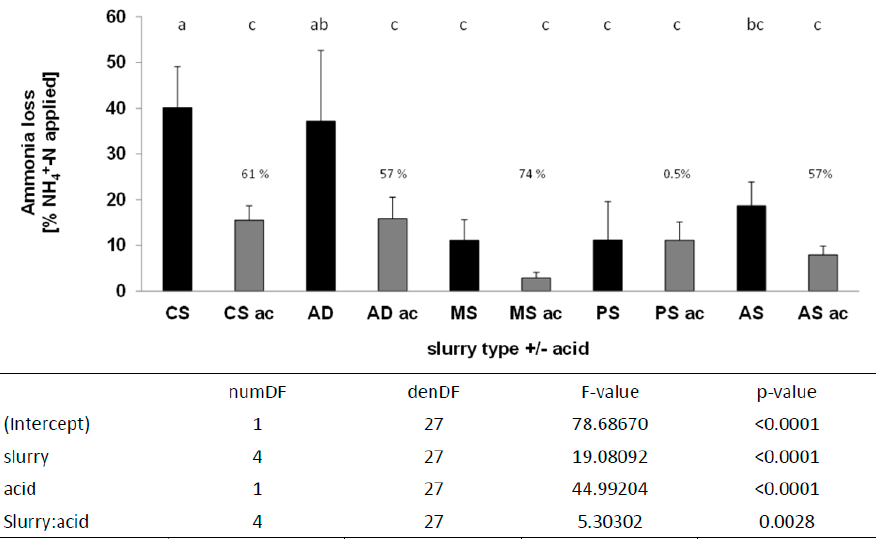
Figure 3. NH 3 loss after application of five different slurries with and without acidification by trail hoses, first winter wheat trial. Applied NH 4+ -N kg ha − 1 : CS = 84.8, AD = 79.5, MS = 78.75, PS = 84.42, and AS = 79.5, n = 4; mixed effects model, HSD test p < 0.05, n = 4; lowercase letters indicate significant differences between treatments; CS, cattle slurry; A, anaerobic digestate; MS, mink slurry; PS, pig slurry; AS, liquid phase separated A; ac, acidification.